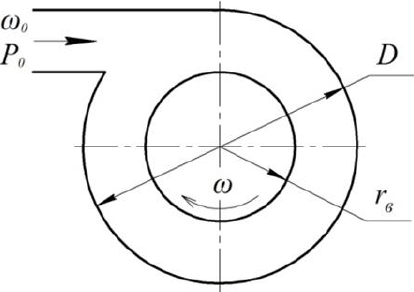
Figure 1. Model of the translational − rotational movement of the liquid flow. In the context of the steady translational − rotational movement of incompressible liquid along the tube axis of the vortex heat generator, the rotational velocity depends on the distance to the tube axis r в . In this case, the liquid is affected (conversely to the motion) by the viscosity force (i.e., friction) characterized by the resistance factor ξ